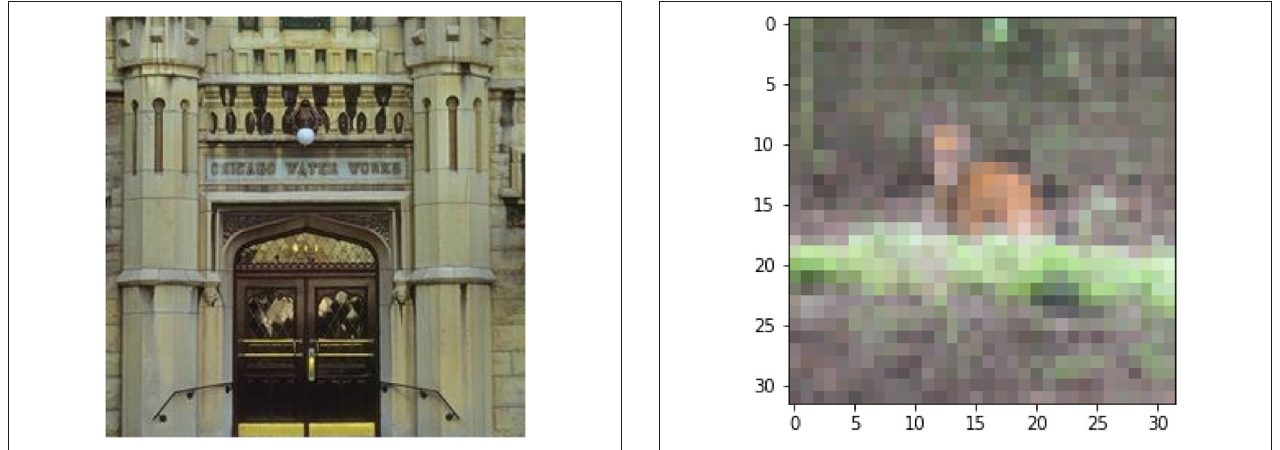
not possible to know which from the context. Here, both labels